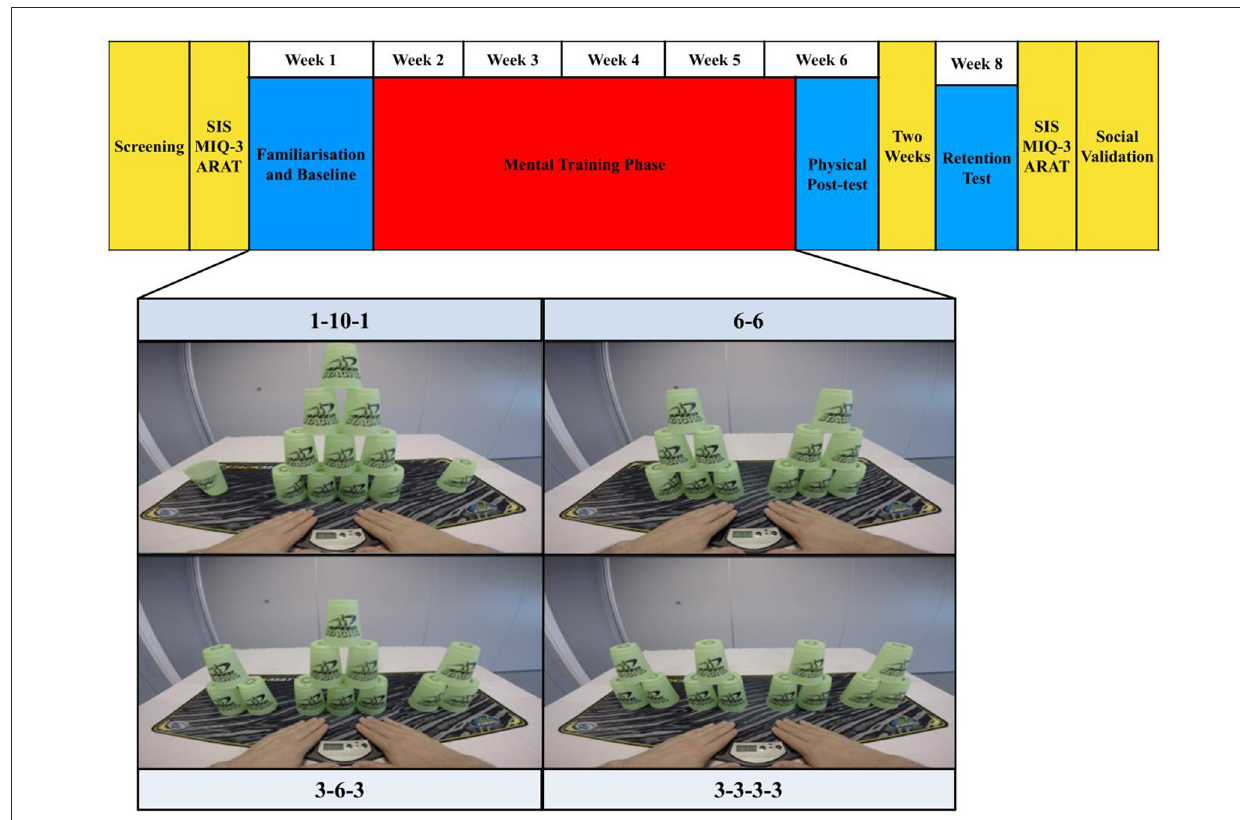
FIGURE1 Research design and task. The structure of the research design is displayed across the top of this figure. On each practice day, the four cup-stack sequences shown (tasks) were paired with the following practice conditions in a fully counterbalanced order across participants: action observation (AO), motor imagery (MI), motor imagery during action observation (AO + MI) and an unpractised control. On each practice day, participants experienced 16 trials, lasting 5min in total, per practice condition. They physically executed five repetitions of each task at the baseline, post-test, and two-week retention test. Key for additional measures: SIS, Stroke impact scale; MIQ-3, Motor Imagery Questionnaire 3; ARAT, Action Research Arm Test.